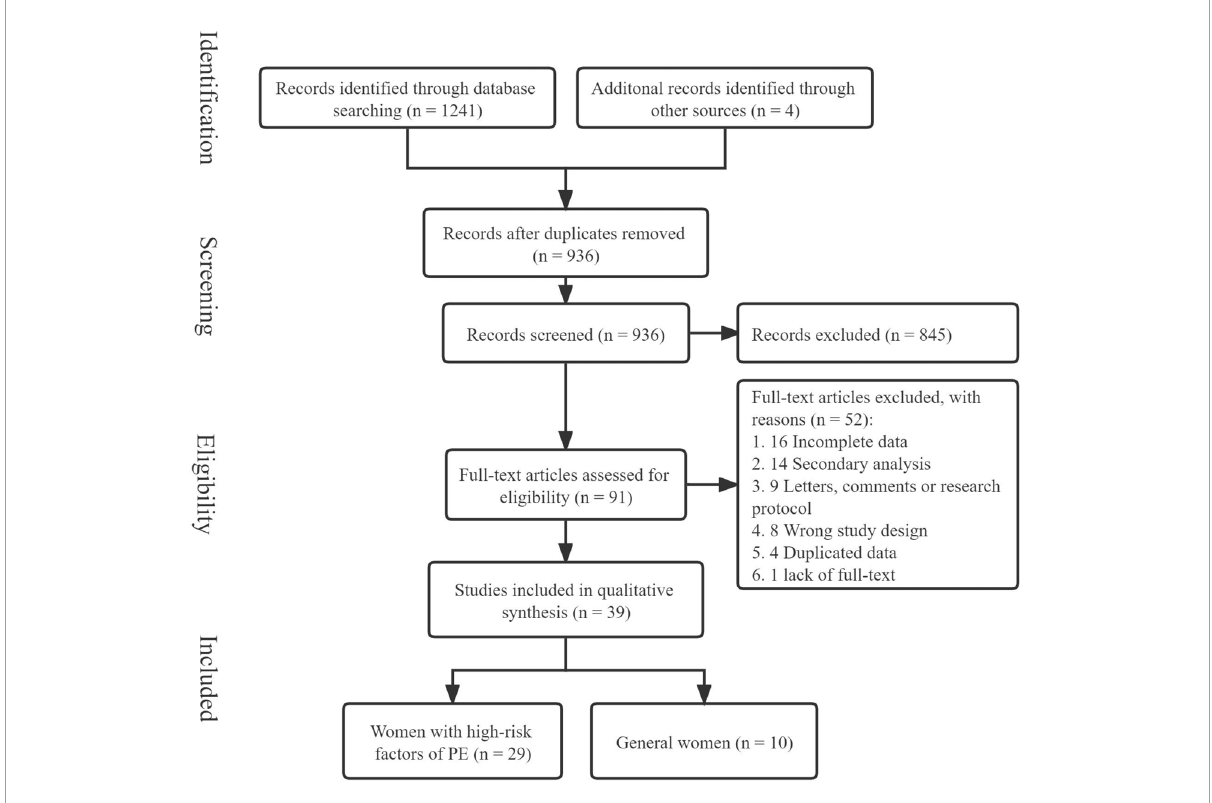
FIGURE1 Flowchart of the screening of studies about aspirin and